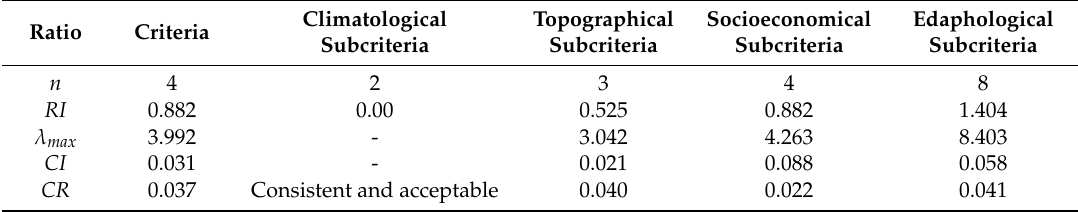
Consistent and acceptable